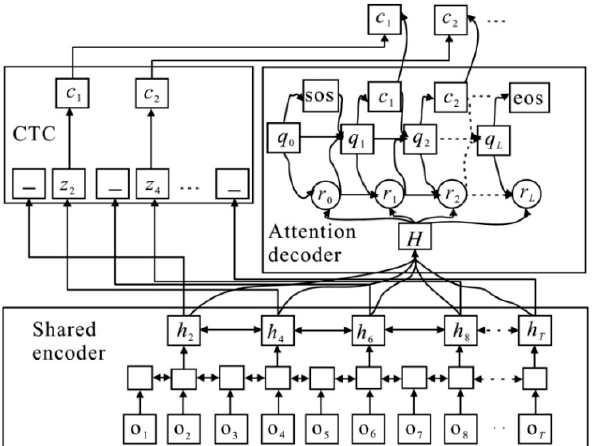
Figure 3. An overall framework of the end-to-end automatic speech recognition (ASR) system based on hybrid CTC/attention architecture.